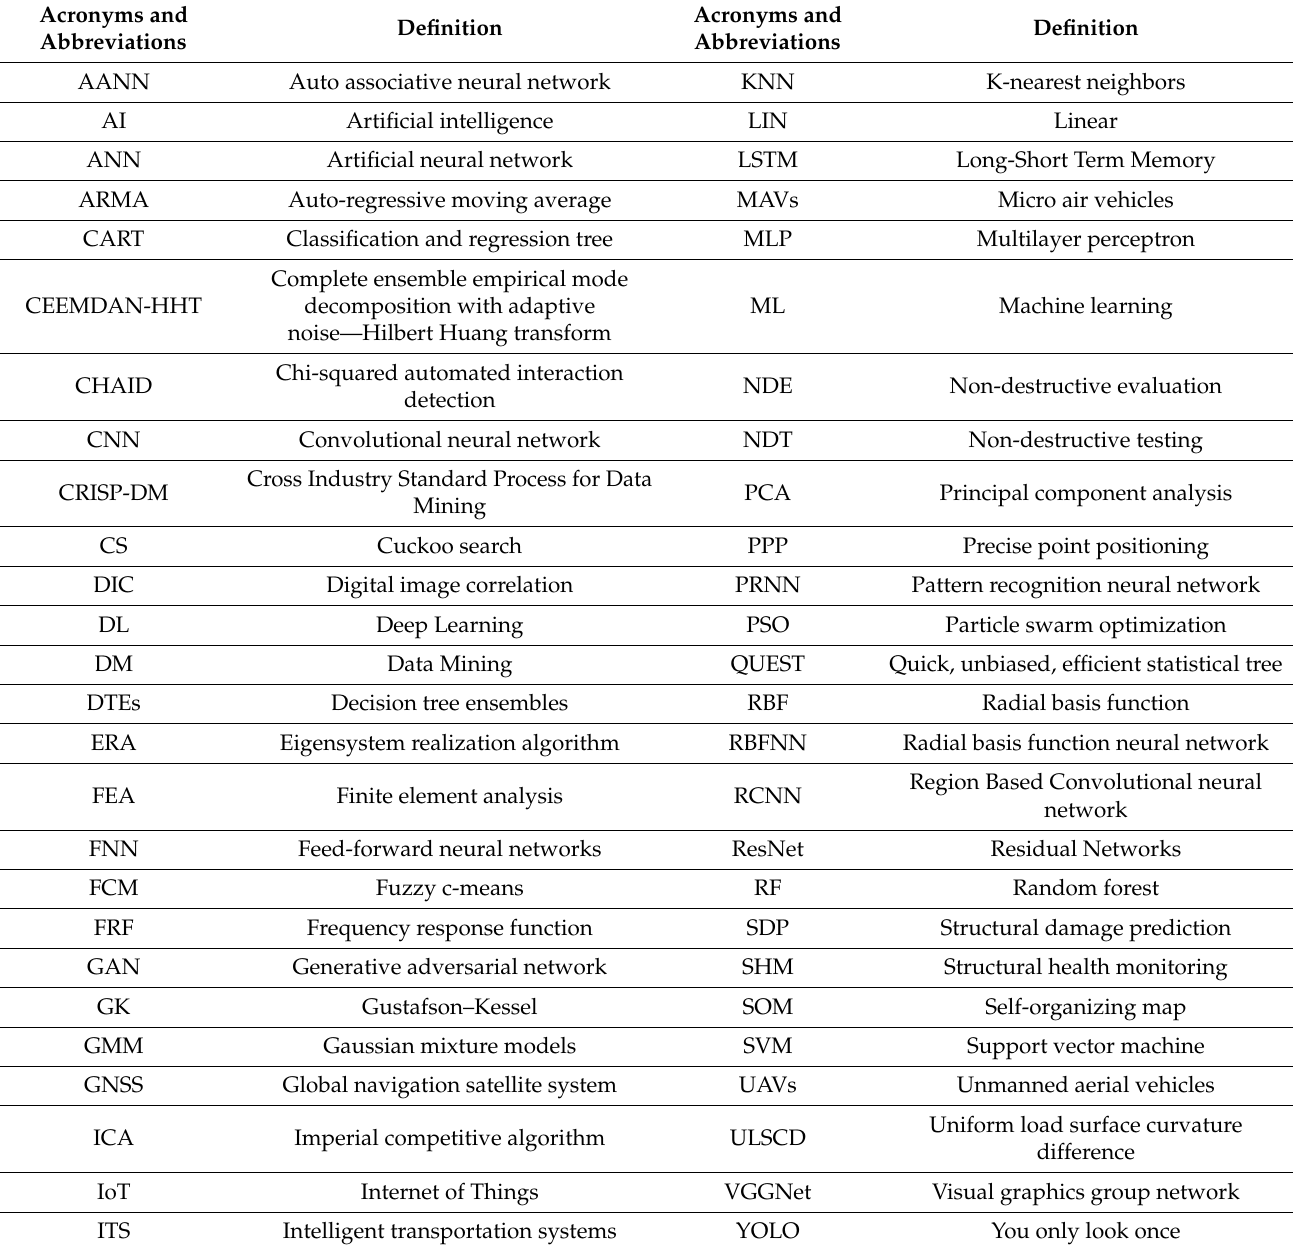
Table 1. List of common abbreviations and